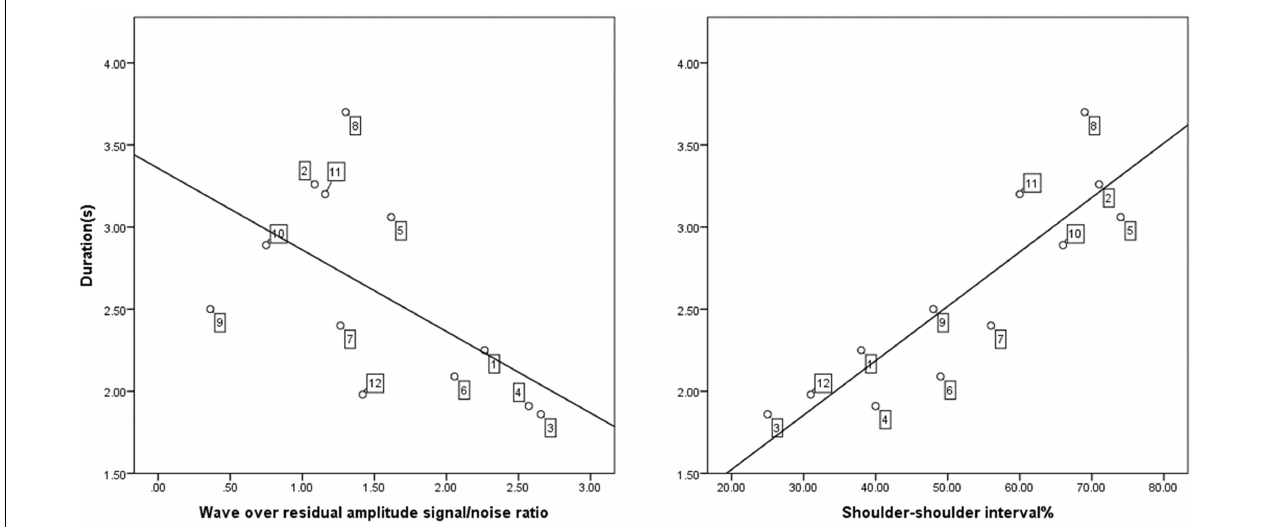
FIGURE 6 | The scatter plot on the left reveals the relationship between the signal to noise ratio of wave amplitude over the residual amplitude and the duration in seconds. The scatter plot on the right, reveals the relationship between the duration in seconds and the shoulder-to-shoulder interval. The numbers anchored to the data points along the regression line denote the individual participants designation (e.g., 10 = participant 10). The position of participant designation denotes the ranking of more successful (e.g., 6, 12) to least successful (e.g., 8, 11)